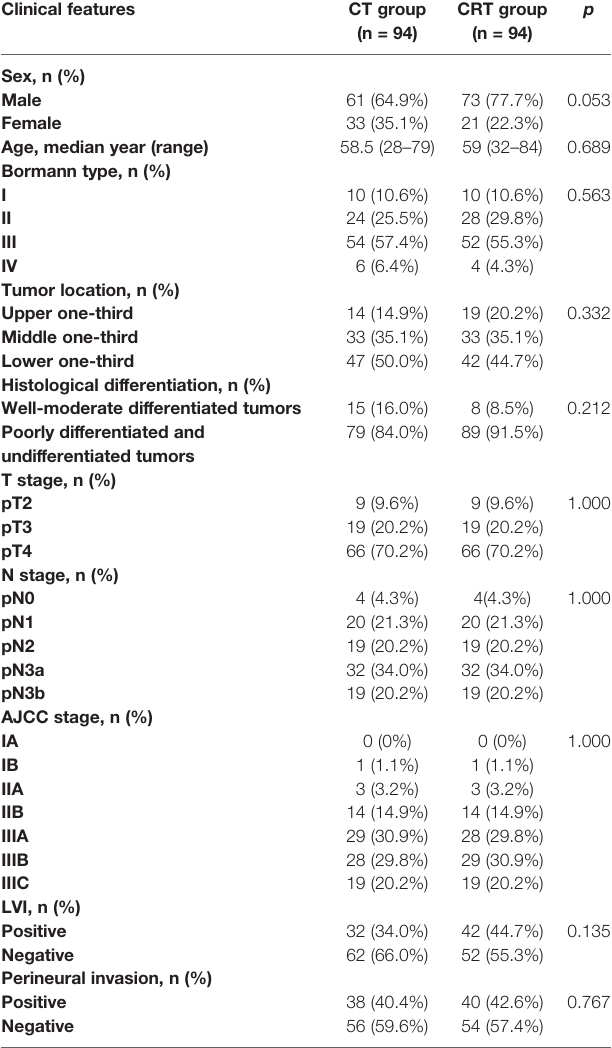
TABLE 1 | Clinicopathological characteristics of 188 gastric cancer